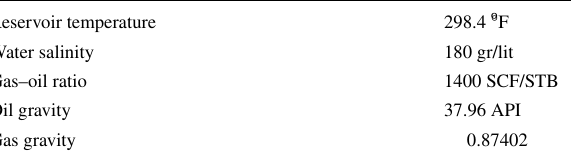
Fig. 5 Results of two-phase flow empirical correlations in wellbore Table 8 Input parameters of regression operation Reservoir temperature